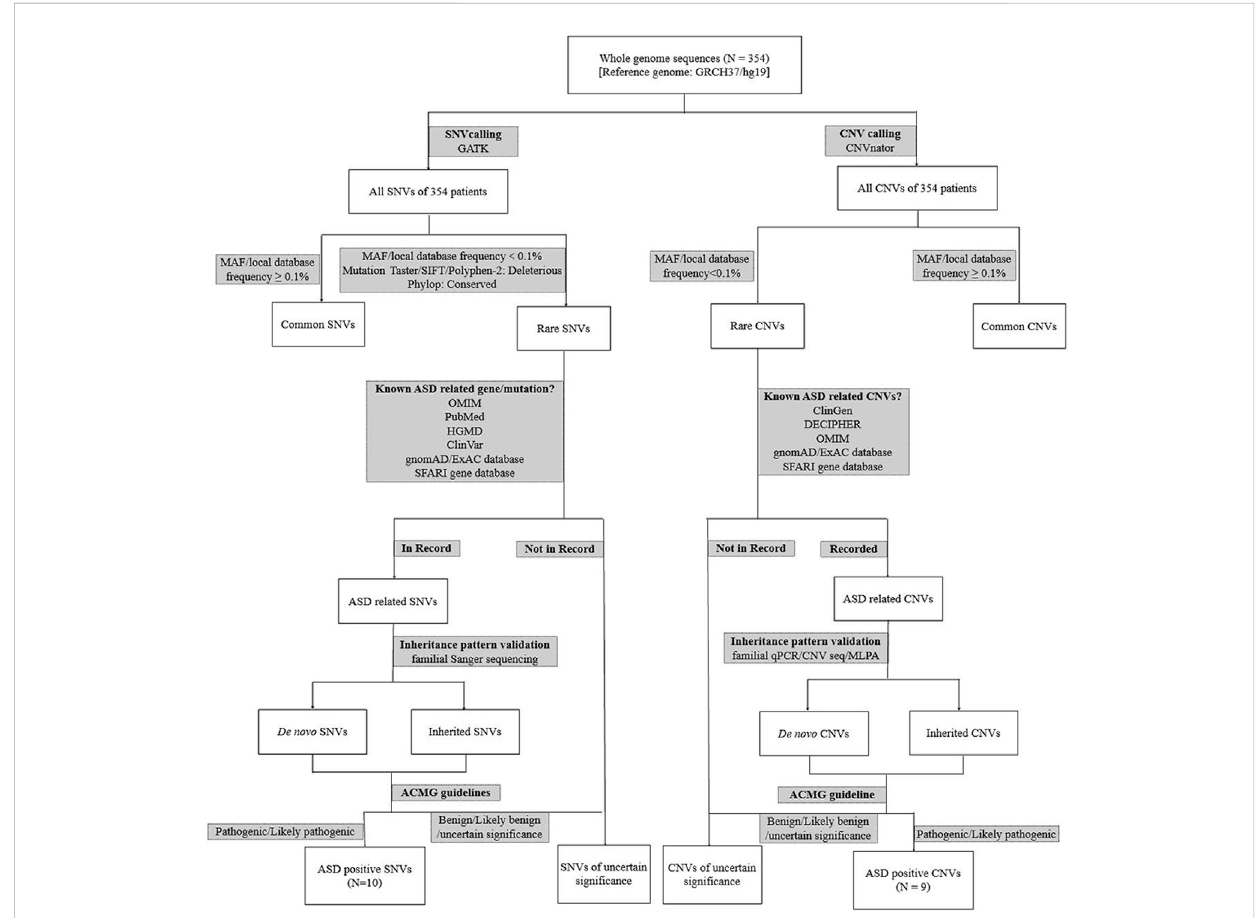
FIGURE 2 The detailed genomics diagnosis pipeline of ASD patients. qPCR: quantitative PCR; WGS: whole genome sequencing; SNV: single nucleotide variation; CNV: copy number variation; CNV seq: CNV